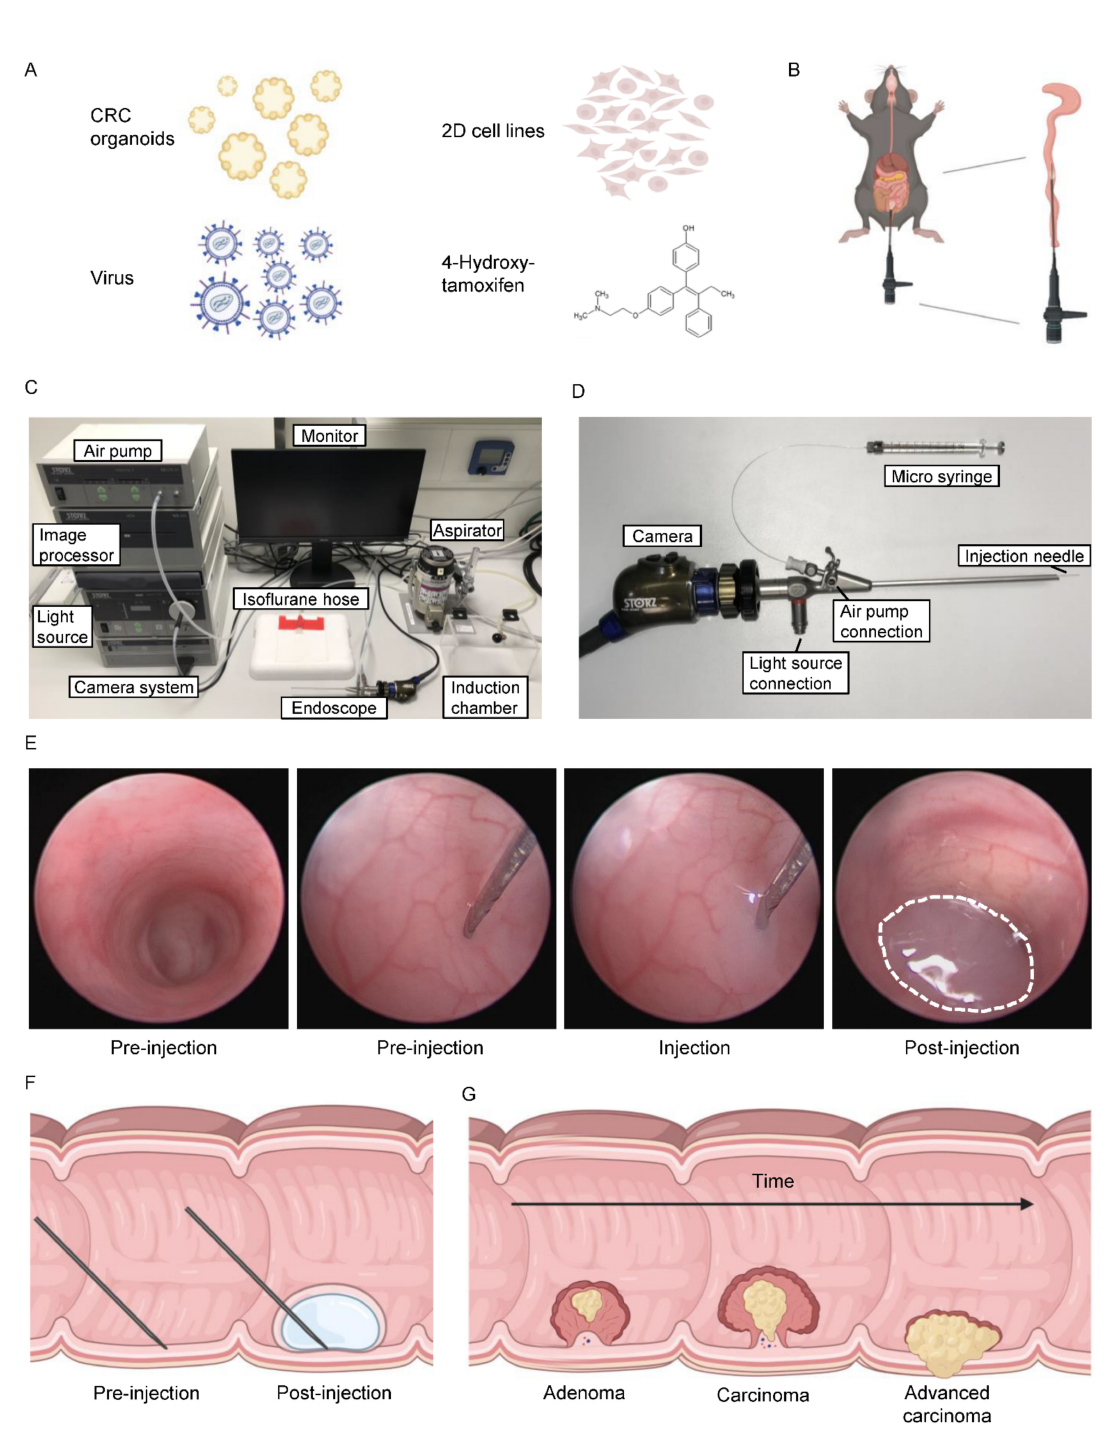
Figure 1. Colonoscopy-guided mucosal needle injection. ( A ) Overview of substances that can be delivered by needle-guided intra-colonic injection. ( B ) Illustration of colonoscopy technique. The endoscope is inserted into the rectum and the injection is performed in the mid-distal colon. ( C ) Set-up for the colonoscopy-guided injection. ( D ) Set-up of endoscope probe with injection needle. ( E ) Colonoscopy images showing the injection procedure. The needle is placed against the colon wall before the splenic flexure and the injection is applied into the mucosa. ( F ) Illustration of mucosal needle injection of substances from A. The injection is performed directly under the mucosa. ( G ) Schematic representation of tumor development and progression in the